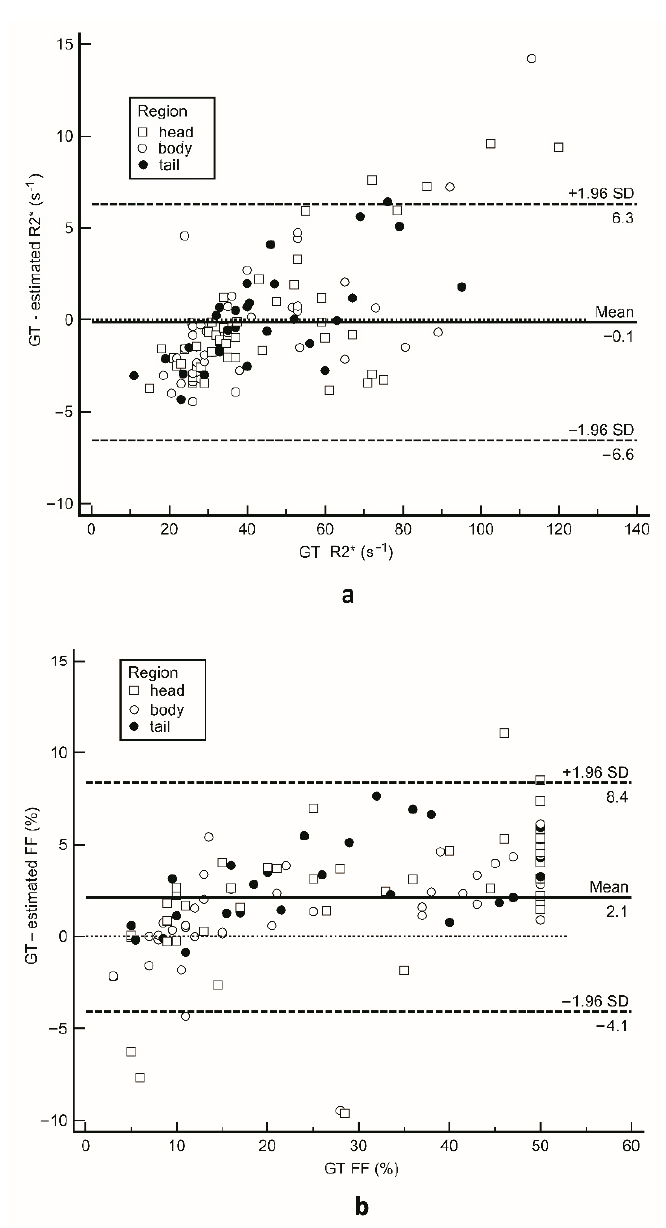
Figure 5. Bland–Altman plots reporting the difference between Ground Truth and estimated R 2* ( a ) and FF ( b ) values among the three pancreatic